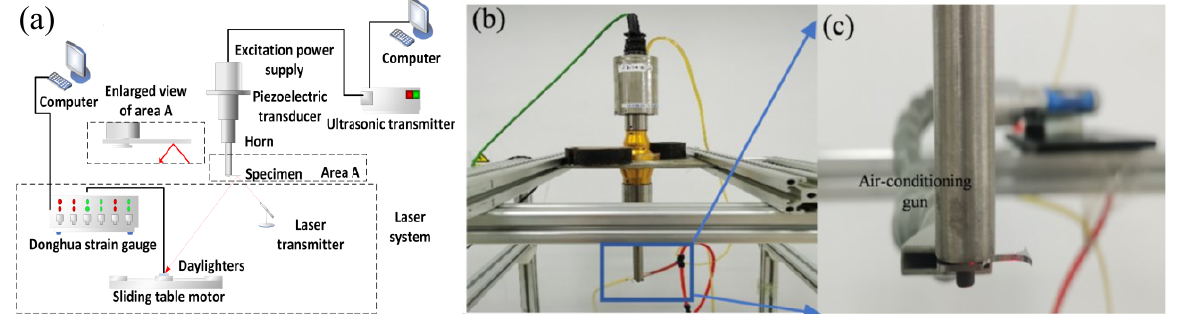
Figure 1. Ultrasonic bending fatigue vibration: ( a ) Schematic diagram of ultrasonic fatigue system; ( b ) Installation of ultrasonic bending equipment; ( c ) transition of a longitudinal wave to a transverse wave.